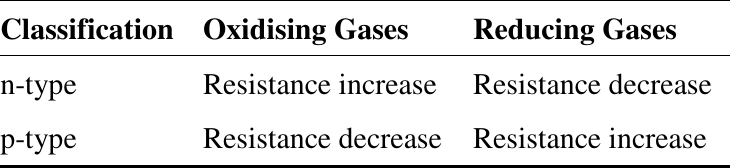
Table 1. Sign of resistance change (increase or decrease) to change in gas atmosphere